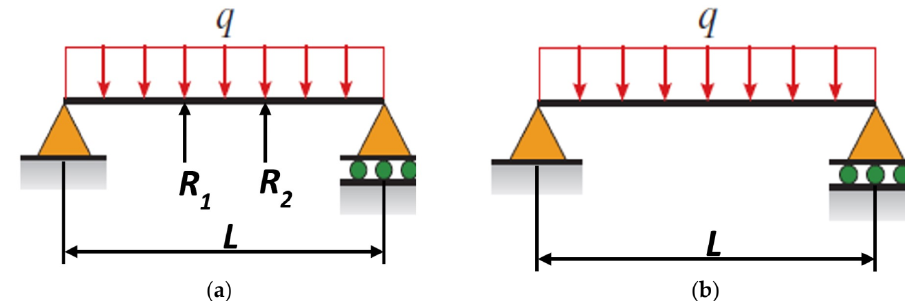
Figure 12. Free body diagrams of the invention. ( a ) Table, ( b ) Chair and stepladder.